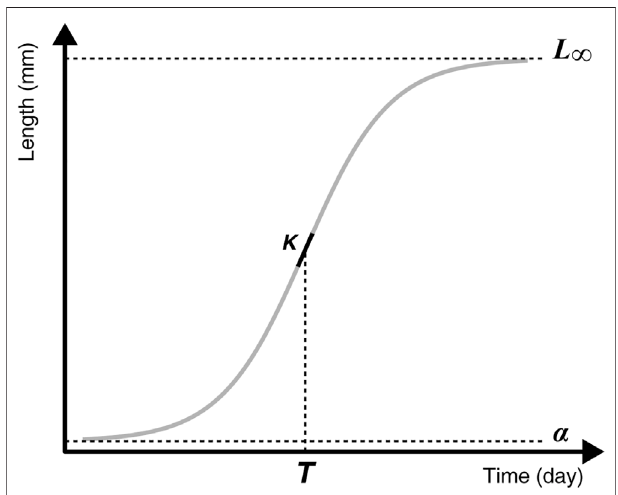
FIGURE 2 | The logistic growth curve with the four parameters: asymptoticsize( L ∞ ),minimalasymptotic size( α ),timeatthein fl exionpoint( T ), and maximum growth rate ( K ), derived from the scale parameter δ and computed as K (cid:2) ( L ∞ - α )/(4 δ ).